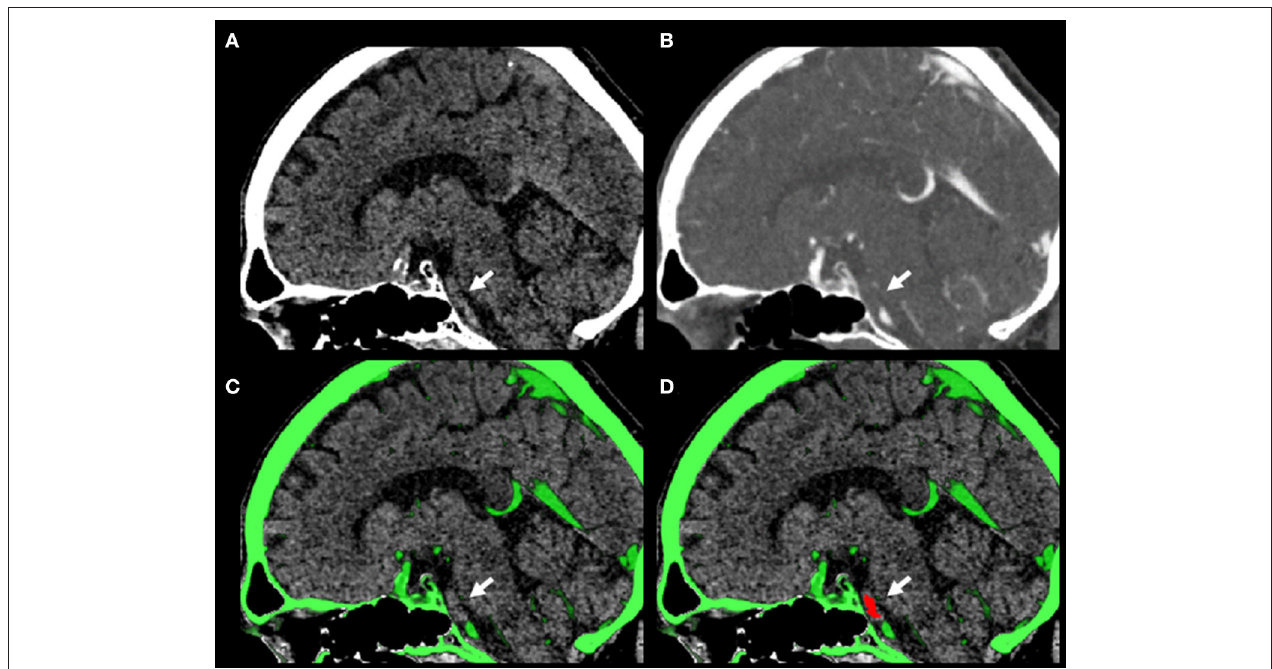
FIGURE 1 | Example of a 66-year-old male patient presenting with a National Institutes of Health Stroke Scale (NIHSS) score of 20. No intravenous thrombolysis was performed due to arrival beyond 4.5h since symptom onset. Mean thrombus attenuation increase (TAI) was 9.11 Hounsfield units, and clinically determined most likely stroke etiology was large artery atherosclerotic (LAA). Endovascular therapy was performed using a Sofia 6F (Plus) device. The patient was discharged with an NIHSS score of 10 and a 3-month follow-up modified Rankin Scale (mRS) score of 4. (A) Non-contrast computed tomography (NCCT). (B) CT angiography (CTA). (C) Overlay of NCCT and CTA. (D) Overlay of NCCT and CTA with segmentation of the thrombus in the basilar artery. Arrows indicate location of the thrombus. Shown are sagittal slices due to better visualization of the extent of the thrombus; actual thrombus segmentation was performed on axial slices.